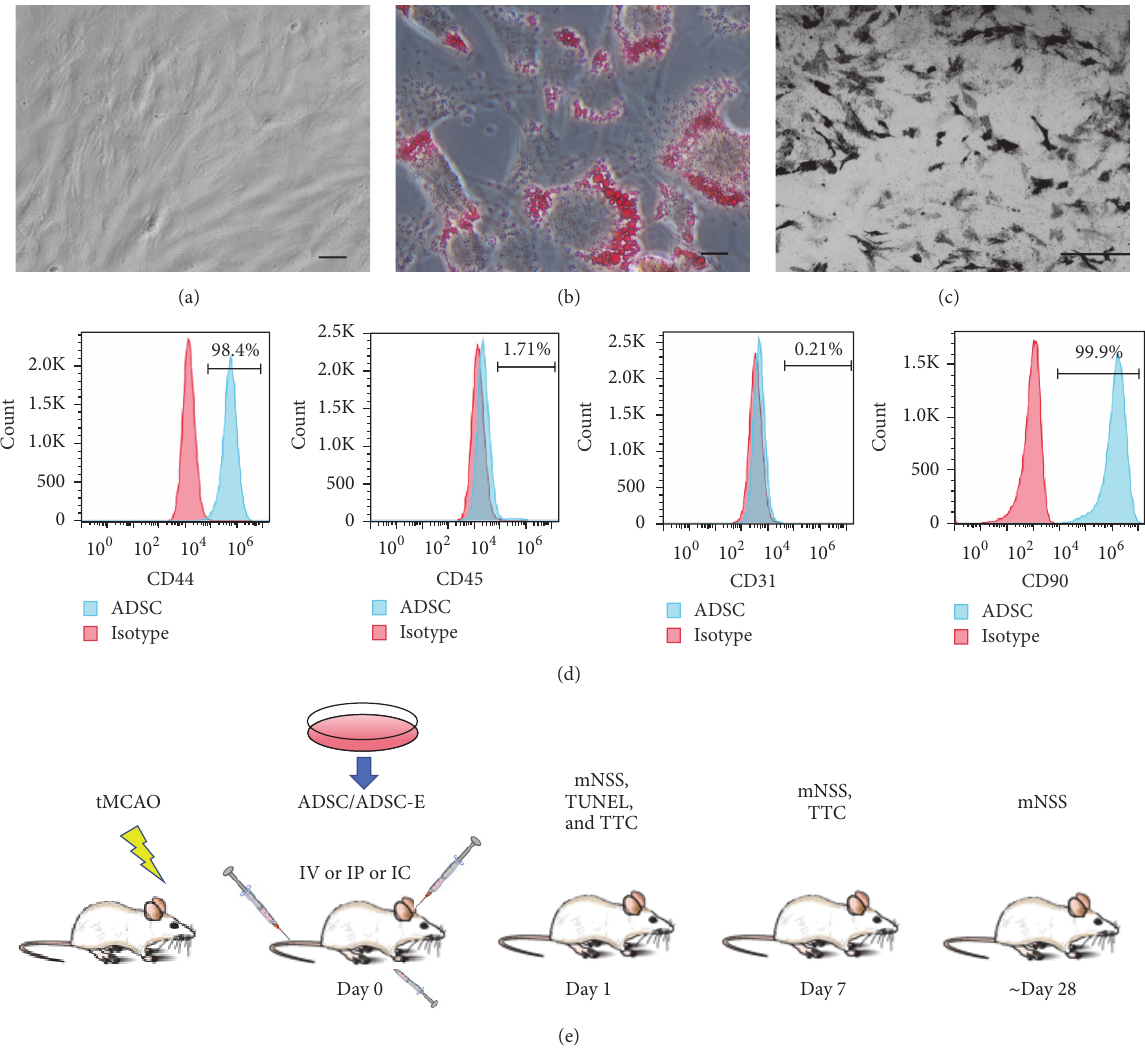
Figure 1: ADSCs characterization and ADSC treatment regime. ADSC were isolated from adipose tissue surrounding the enterocoelia. As ADSC approached confluence, they showed a more spindle-shaped, fibroblastic morphology. Scale bars: 100um (a). (b) ADSC were cultured in the adipogenic induction medium for 14 days. Oil red was used to validate the induction. The intracellular lipid droplets were showed as positive red loci. Scale bars: 100 um (c). ADSC were cultured in the osteogenic induction medium for 21 days. Von Kossa staining showed that a calcified extracellular matrix of induced ADSC was detected. Scale bars: 500 um (d). Flow cytometry analysis was used to measure the surface marker of ADSCs. ADSCs were negative for leukocyte markers, CD45 (1.71%) and CD31 (0.21%), and positive for mesenchymal stem cell markers, CD44 (98.4%) and CD90 (99.9%). (d). ADSC/ADSC-E were administrated through IV or IC or IP 1 hour after tMCAO